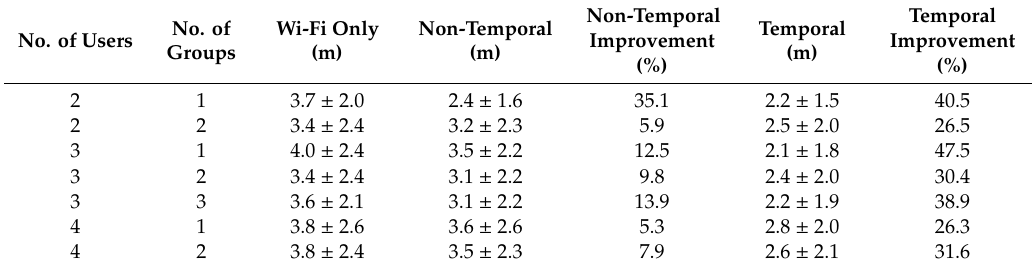
Table 4. Average positioning errors for all devices together in designed scenarios.